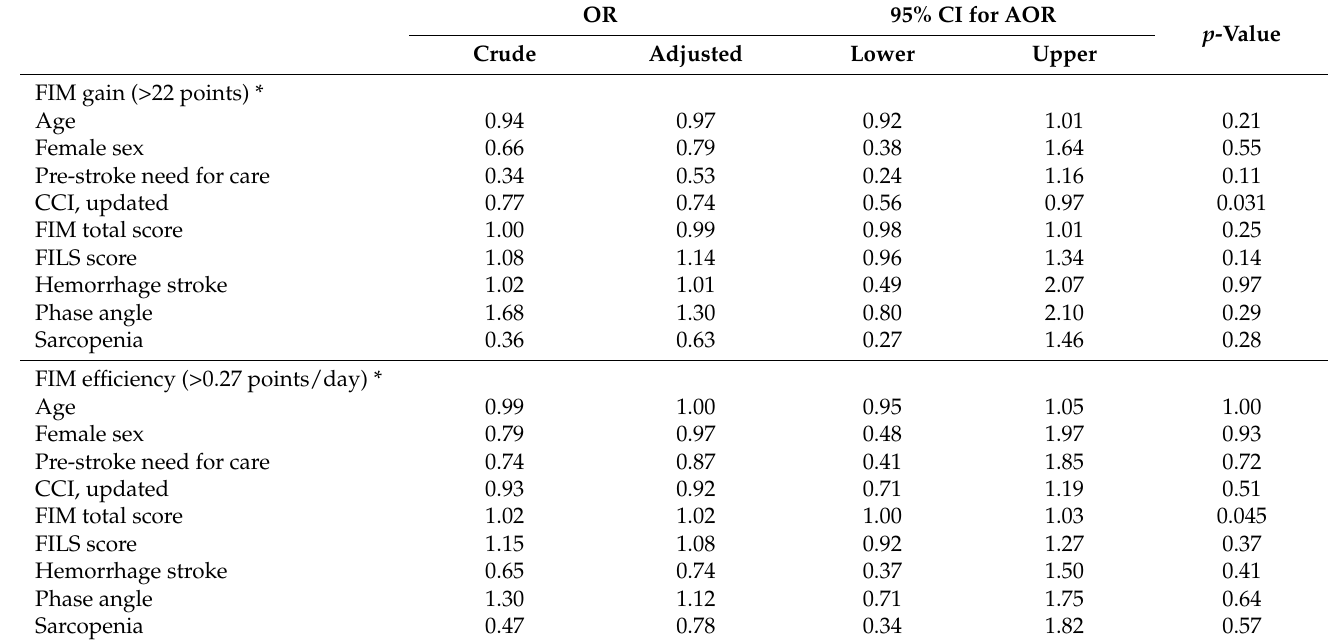
Table 4. Logistic regression analysis for FIM gain and FIM efficiency